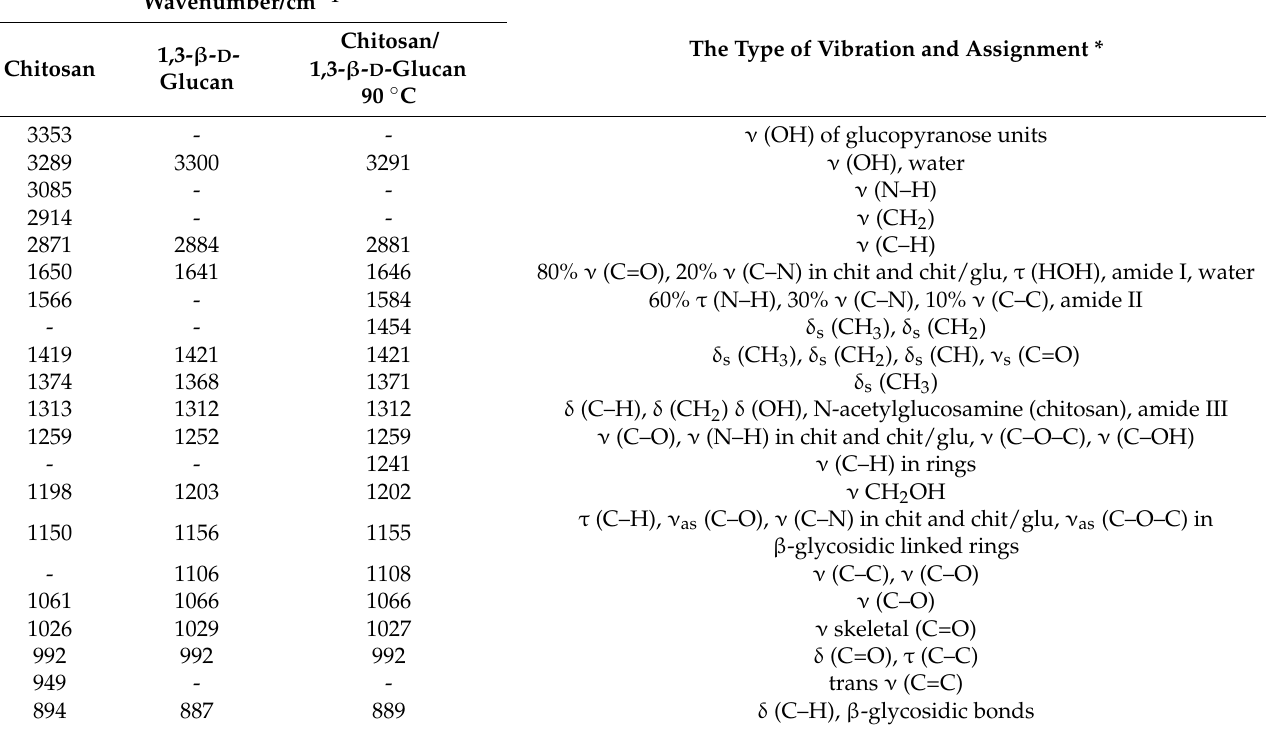
Table 1. The most prominent bands detected in ATR FT-IR spectra of chitosan, 1,3- β - D -glucan, and chitosan/1,3- β - D -glucan films cross-linked at 90 ◦ C.